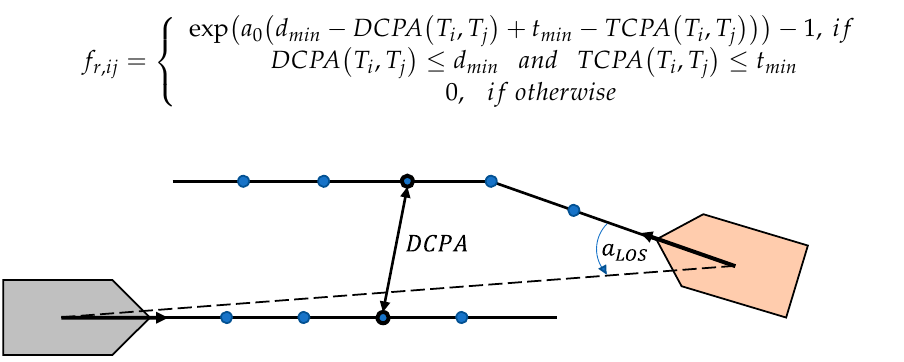
Figure 2. Illustration of the CPA metrics, as well as the LOS angle